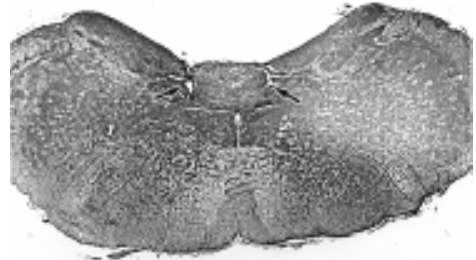
Figure 4 - Photomicrograph of a coronal section of the brainstem of one rat representative of the group that received bilateral mi- croinjection of WIN showing the bilateral sites of microinjections in the lateral commissural NTS (Nissl, 120X).